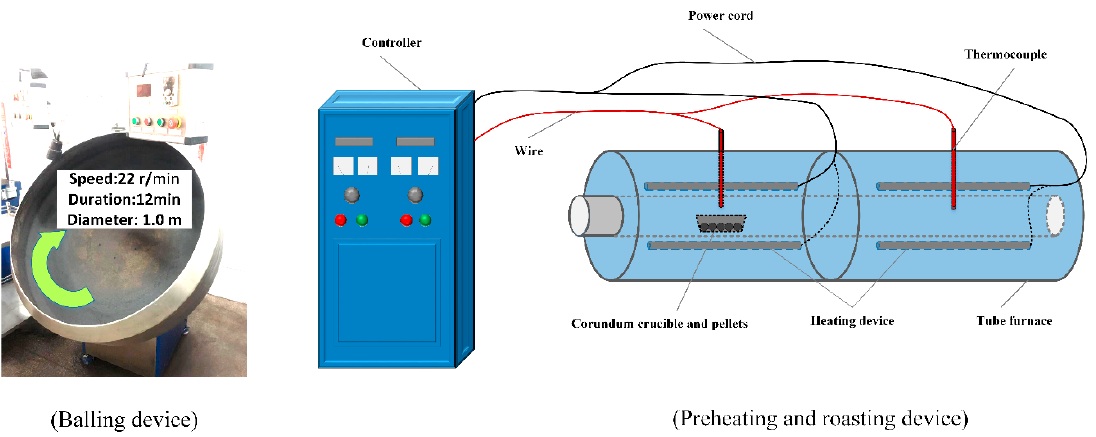
Figure 3. Schematic diagram of balling, preheating and roasting devices.